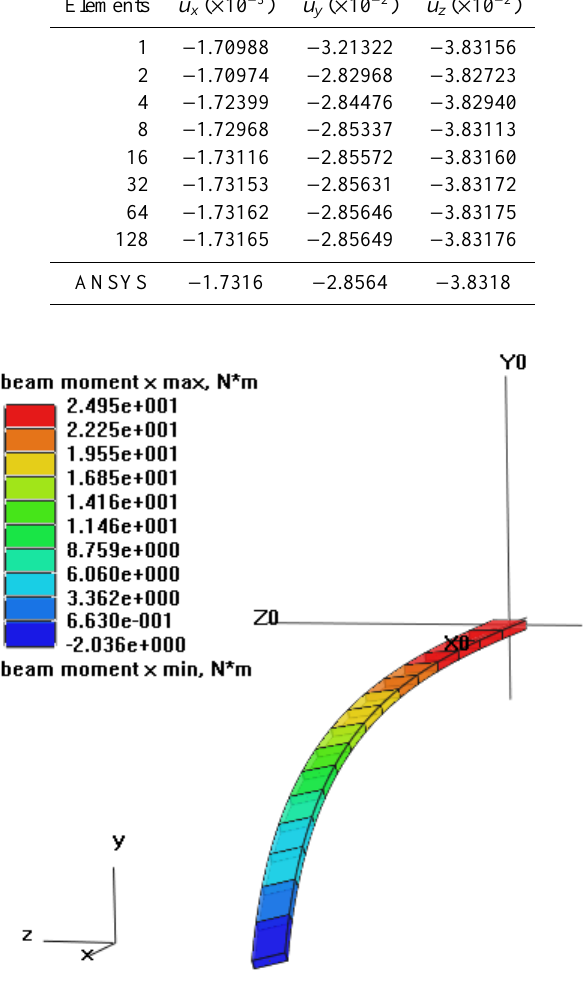
Figure 7. Deformation of the beam in Sect. 6.3 with color-plot of the torsional moment.